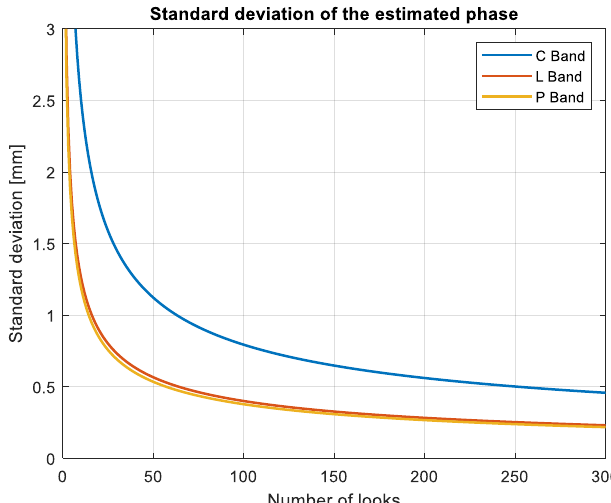
Figure 5. Standard deviation of the estimated phase versus the number of independent looks used for the estimate. For this processing we used a covariance matrix modelled as in (7), with γ 0 = 0.7, ρ = 0.975, T = 6 as suggested in [8].